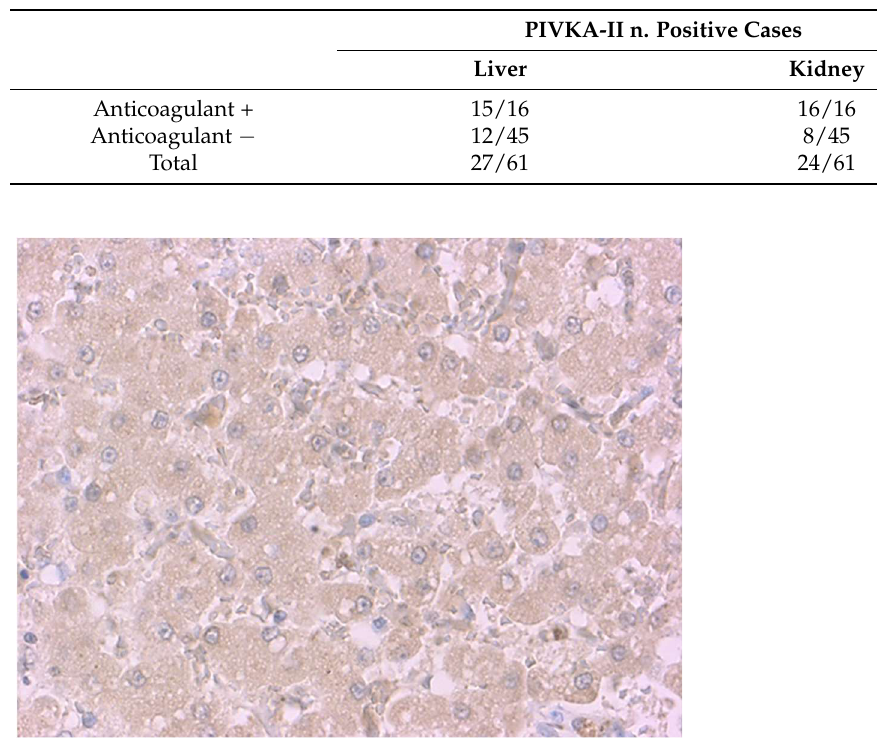
Table 3. Correlation between PIVKA-II immunohistochemistry on the liver and kidneys, as well as toxicological results.